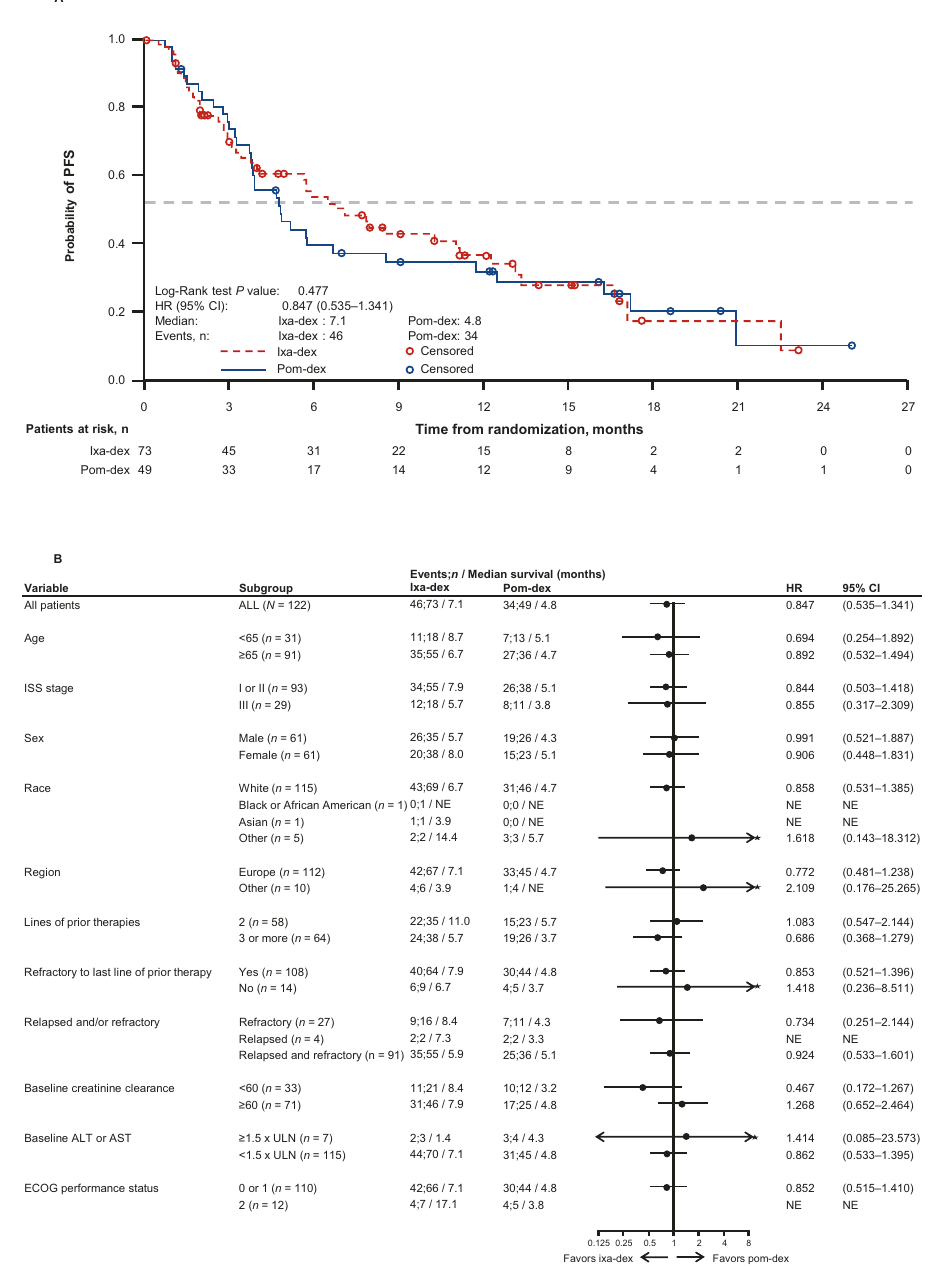
Fig. 2 PFS with ixa-dex vs pom-dex in the ITT population. A Kaplan – Meier analysis of PFS and ( B ) Forest plot of PFS in prespeci fi ed subgroups based on patient and disease characteristics. ALT alanine aminotransferase, AST aspartate aminotransferase, CI con fi dence interval, dex dexamethasone, ECOG Eastern Cooperative Oncology Group, HR hazard ratio, ISS International Staging System, ITT intent-to-treat, ixa ixazomib, NE not estimable, PFS progression-free survival, pom pomalidomide, ULN upper limit of